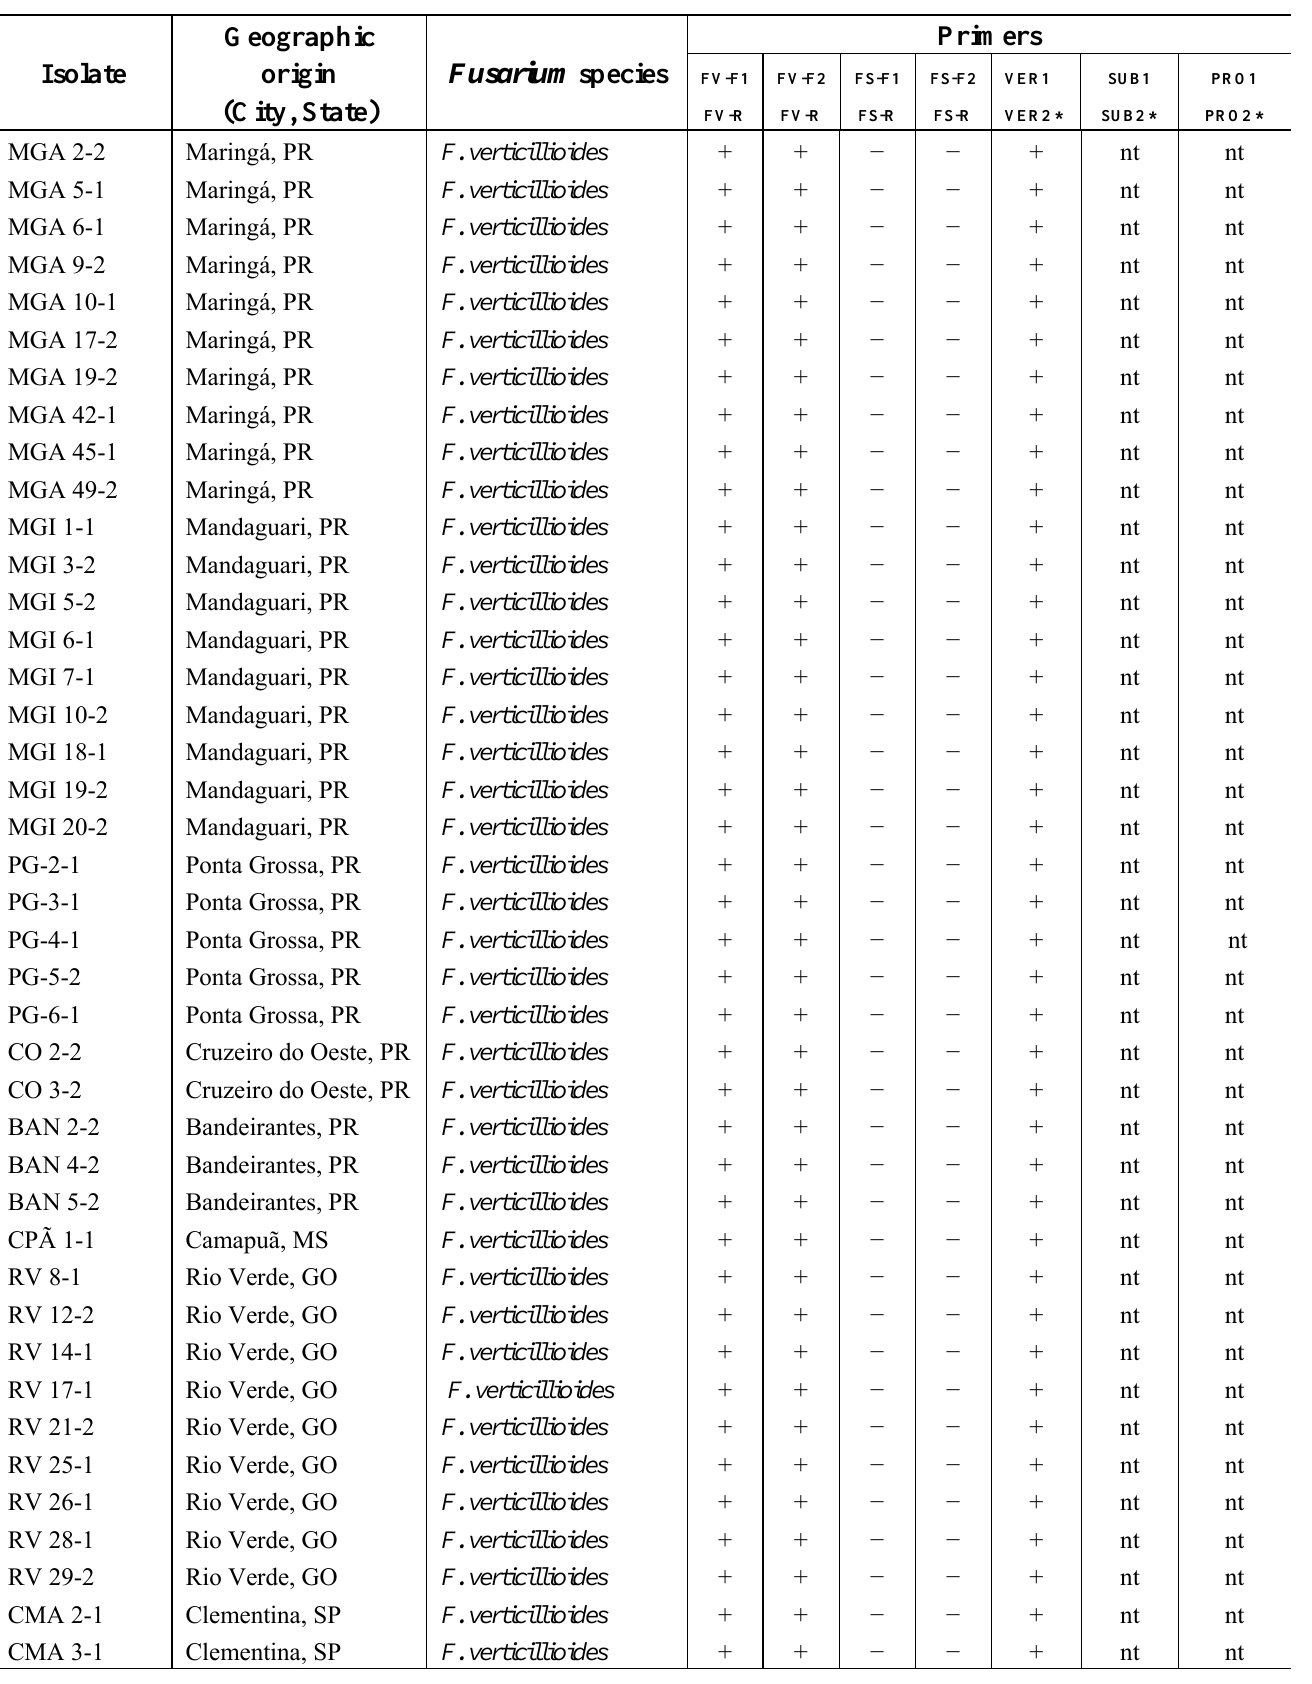
Table 2. Fusarium isolates obtained from maize seeds and the PCR results with the indicated primers. Geographic Isolate origin (City,